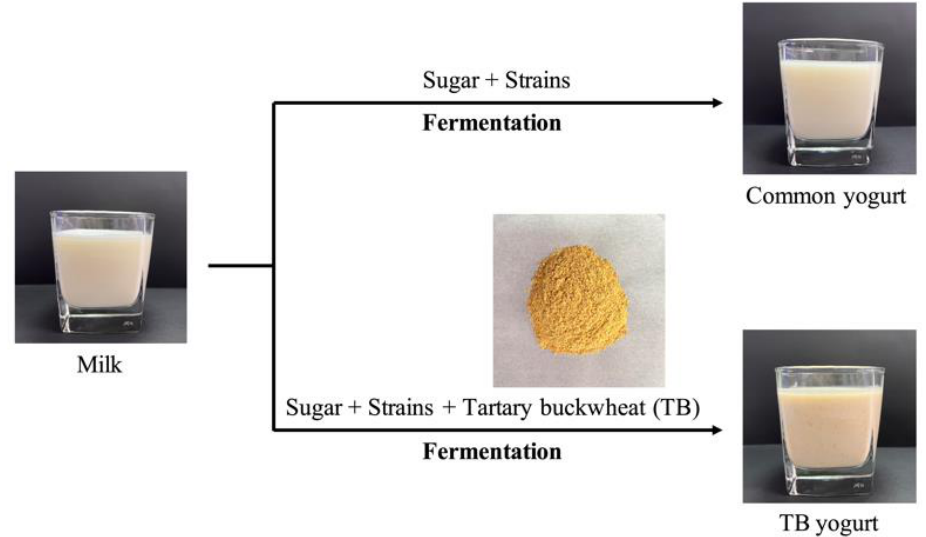
Scheme 1. Flowchart for manufacturing process of common yogurt and TB yogurt.